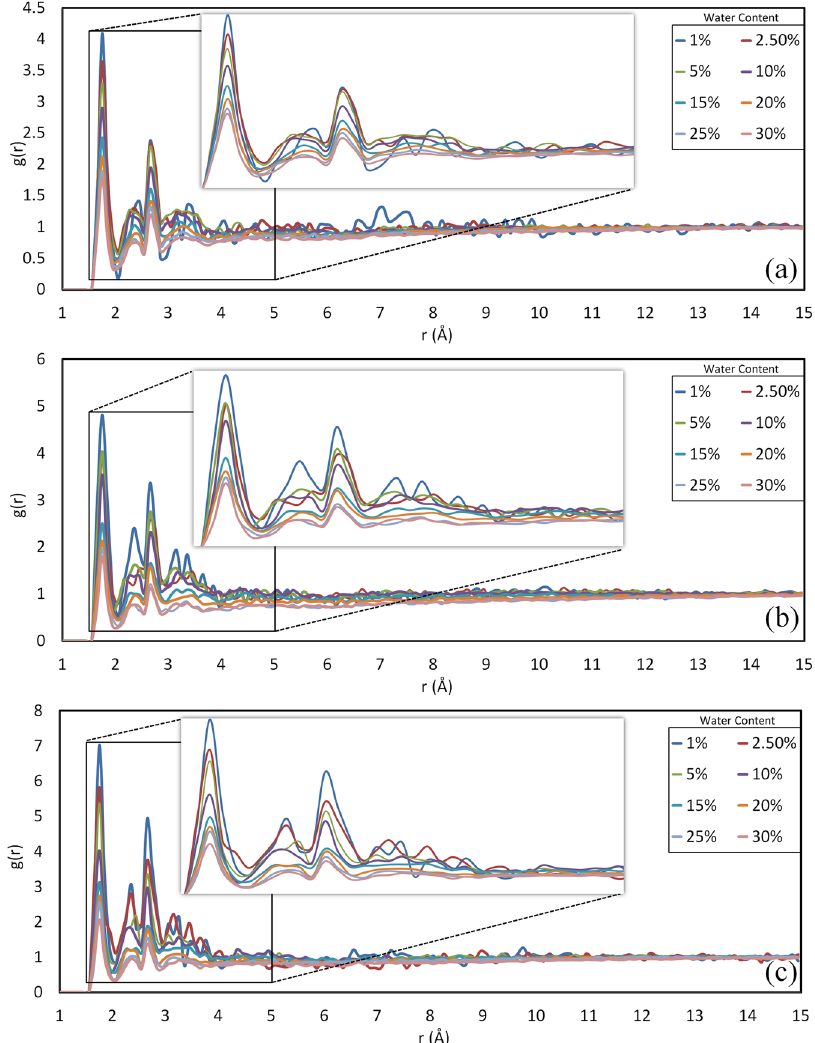
Figure 5. Radial distribution functions between water molecules and hydroxyl groups of ( a ) Hemicellulose ( b ) LCC ( c ) Lignin. First peaks at 1.75 Å indicate strong and short-range hydrogen bonds between water molecules and polymer chains. Higher peaks of lignin and LCC at 1.75 Å suggest that larger portion of water molecules interacts with lignin and LCC chains than that of